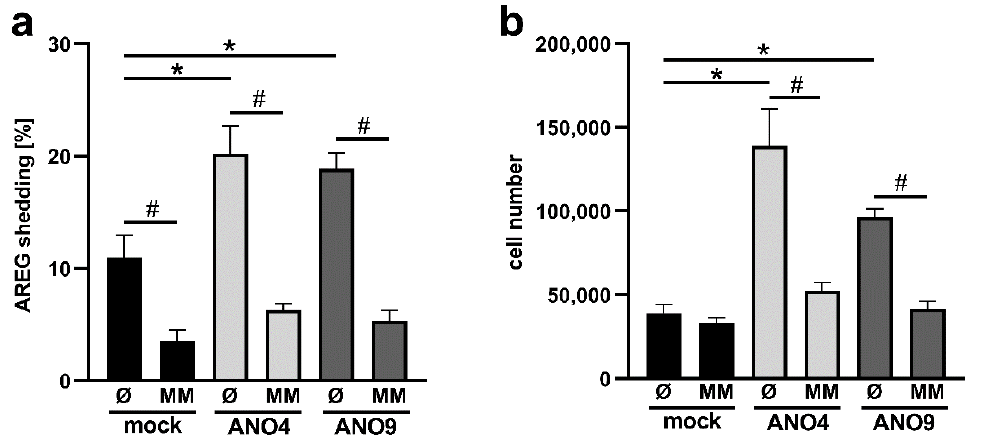
Figure 7. Release of endogenously expressed AREG is constitutively increased upon ANO4- or ANO9-overexpression. HeLa cells were transfected with ANO4 or ANO9 or mock vector. ( a ) Twenty-four hours after transfection cell media were replaced by fresh media. Cells were incubated overnight and then analyzed for the relative amount of shedding products in the supernatant compared to the cell lysate by AREG ELISA. ( b ) Forty-eight hours after transfection, cells numbers were determined. * indicates a significant increase compared to mock-transfected cells, and # indicates a significant decrease compared to corresponding untreated cells (n = 4; p < 0.05; ± SEM). Data were analyzed by one-way ANOVA and Holm–Sidak multiple comparison post hoc test.